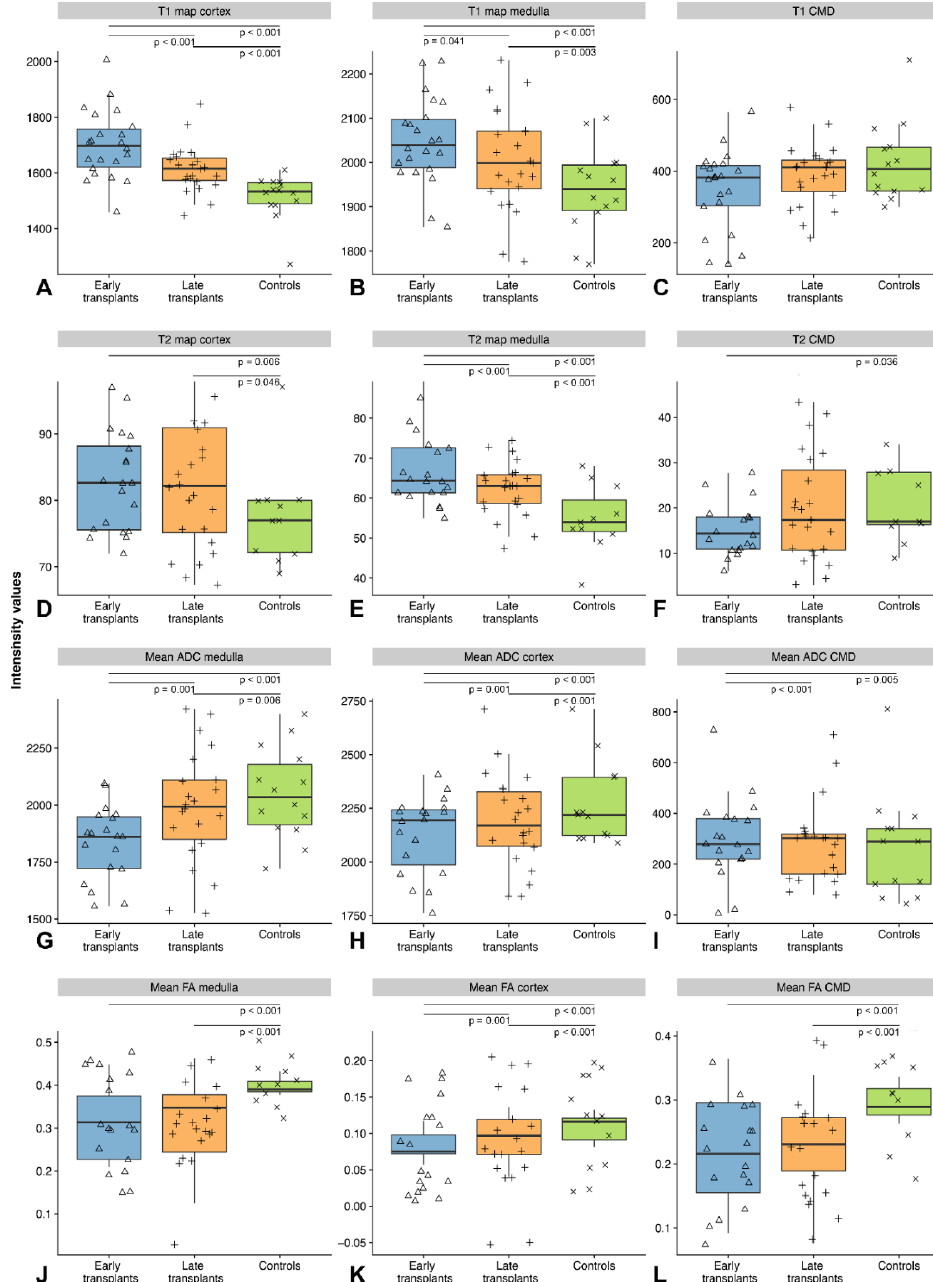
Figure 2. Overview of cortical and medullary T1 and T2 relaxation times, corticomedullary di ff erentiation (CMD) and mean cortical and medullary ADC and FA values across the three groups (early transplants, late transplants, controls): ( A ) the distribution of cortical T1 relaxation times; ( B ) the distribution of medullary T1 relaxation times; ( C ) the distribution of T1 CMD values; ( D ) the distribution of cortical T2 relaxation times; ( E ) the distribution of medullary T2 relaxation times; ( F ) shows the distribution of T2 CMD values; ( G ) the distribution of mean medullary ADC values; ( H ) the distribution of mean cortical ADC values; ( I ) the distribution of ADC CMD values; ( J ) the distribution of mean medullary FA values; ( K ) the distribution of mean cortical FA values; and ( L ) the distribution of FA CMD values. Each graph displays the distribution of the respective parameter across early transplants, late transplants and controls with boxplots as well as the individual data points. Significant di ff erences are indicated by the display of p